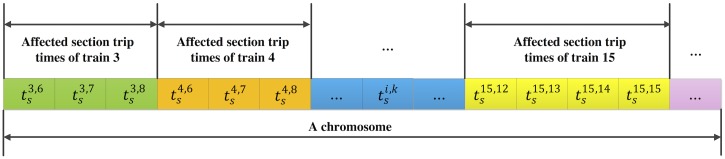
Representation of a chromosome.